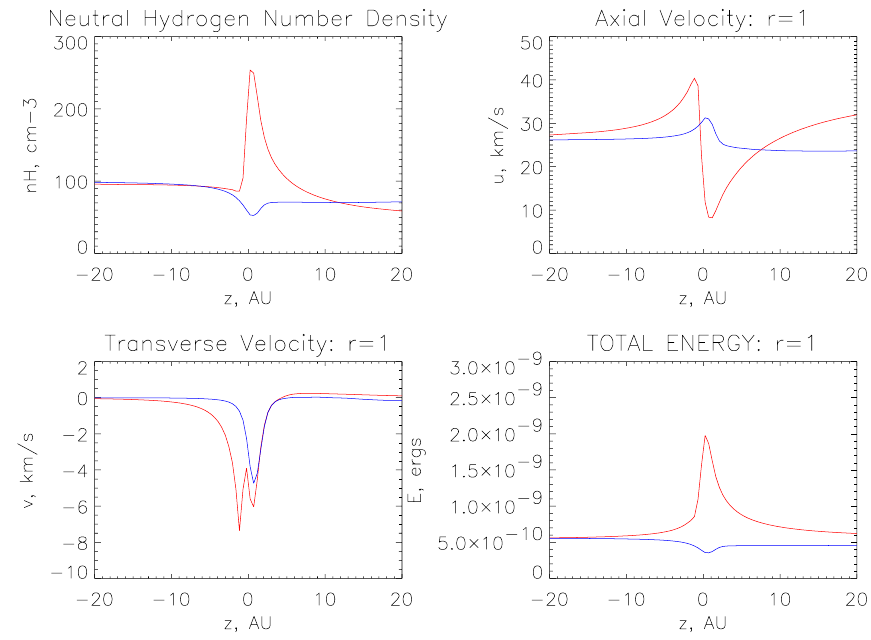
Fig. 3. Number density, axial and transverse components of velocity, and total energy of the IC H-atoms flow versus axial distance z , at a radial coordinate r = 1AU. Input parameters are the same as in Fig. 2, but µ = 0 and 1, shown by red and blue curves,